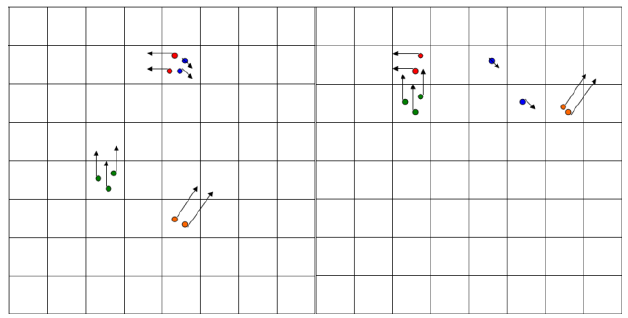
Figure 6. Migration of particles from one cell to another, as prediction is applied [16]. © 2011 IEEE. Reprinted, with permission, from IEEE Transactions on Intelligent Transportation Systems, Vol. 12, No. 4.